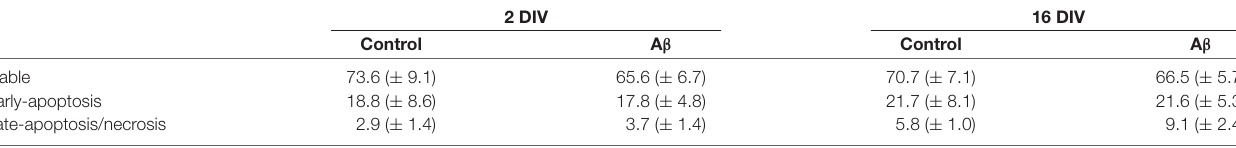
TABLE 1 | Microglia viability is not altered by amyloid- β (A β )